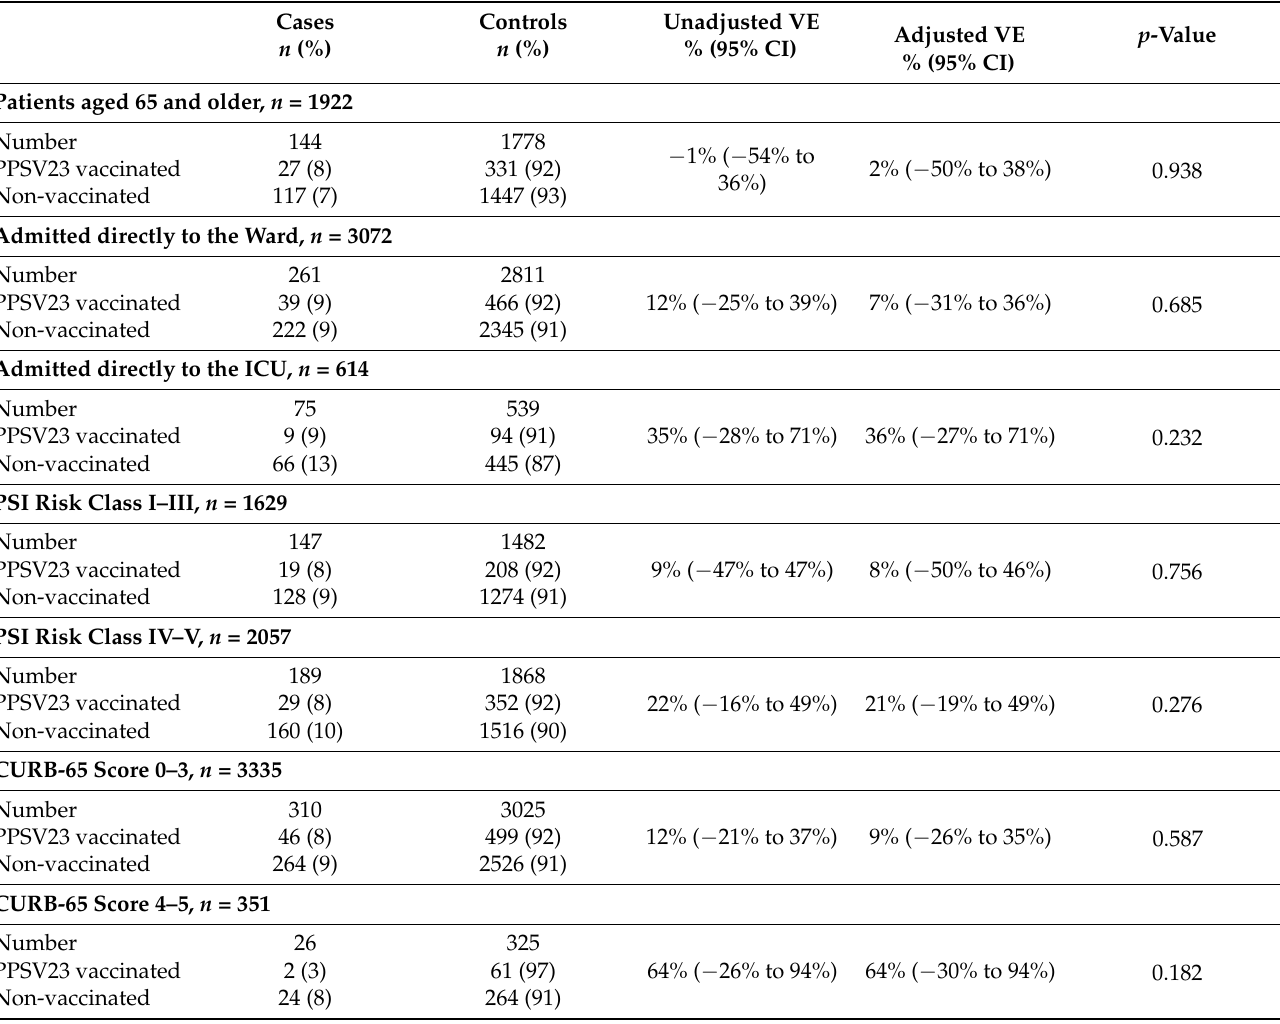
Table 4. Unadjusted and covariate-adjusted PPSV23 vaccine effectiveness for the prevention of hospitalized PPSV23-serotype CAP in various subgroups.